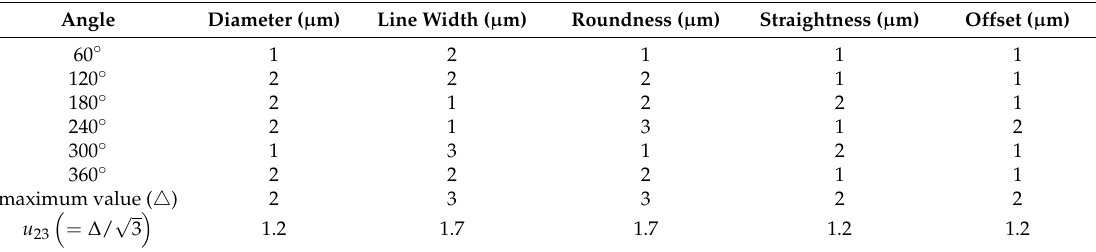
Table 13. Results of indication errors in different attitudes.